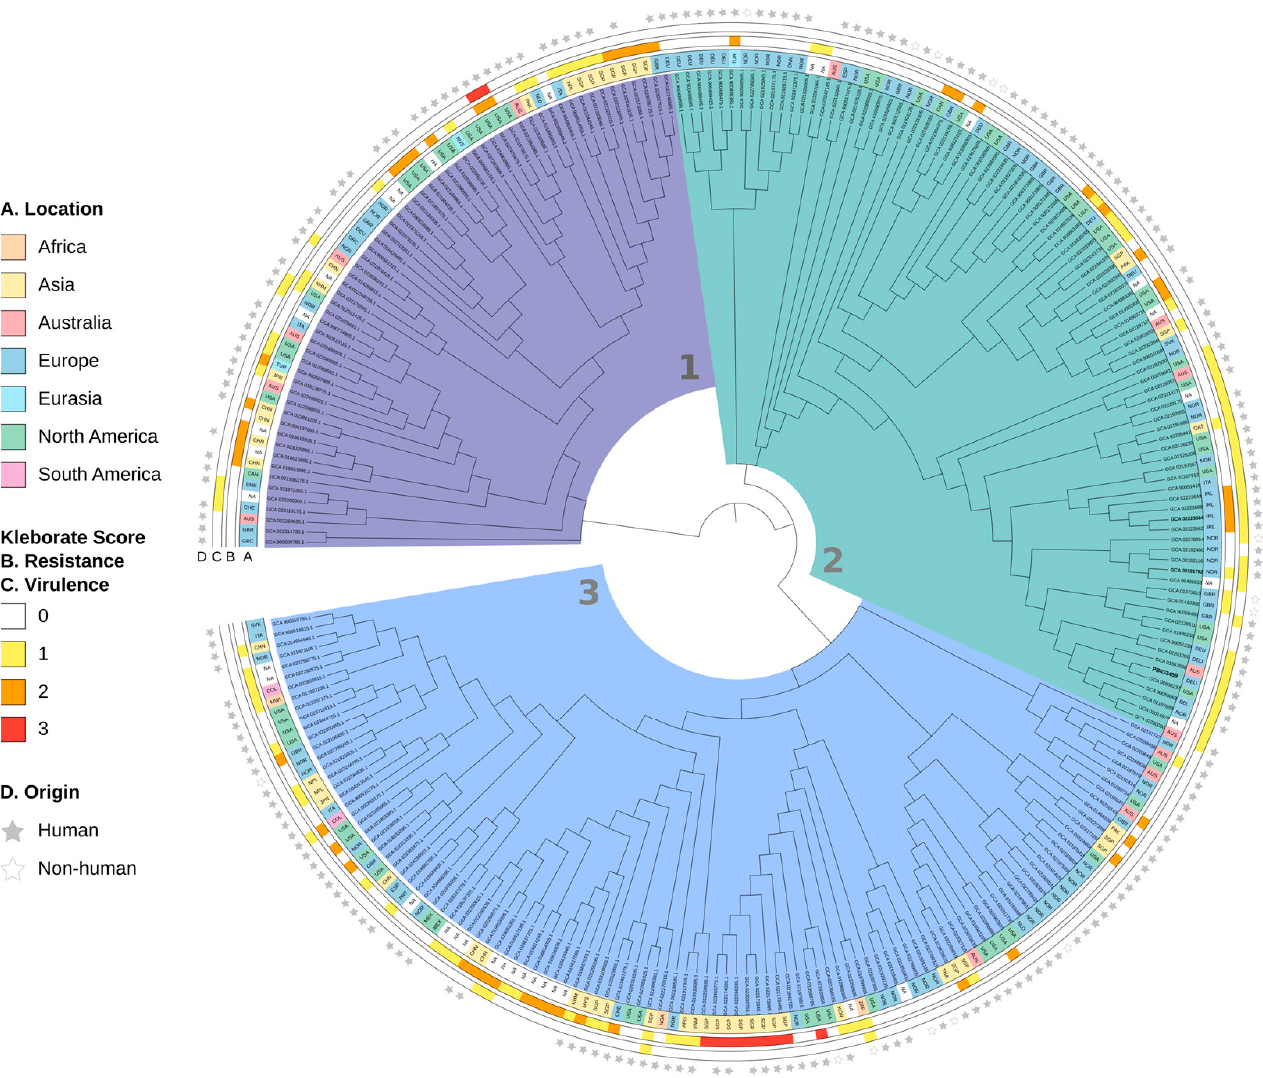
Figure 4. Phylogenetic tree of K. pneumoniae ST20 genomes using a ML approach based on SNP alignments. The labels indicate the accession number (except PBIO3459). Annotations indicate (from inner circle to outer circle): isolate location (A., continents), Kleborate resistance and virulence scores (B. + C.), and isolate human or non-human origin (D.). Countries are abbreviated with alpha-3 codes; NA : not applicable; absent star: not applicable (i.e., no metadata provided). Genomes used for the synteny plot are highlighted in bold.